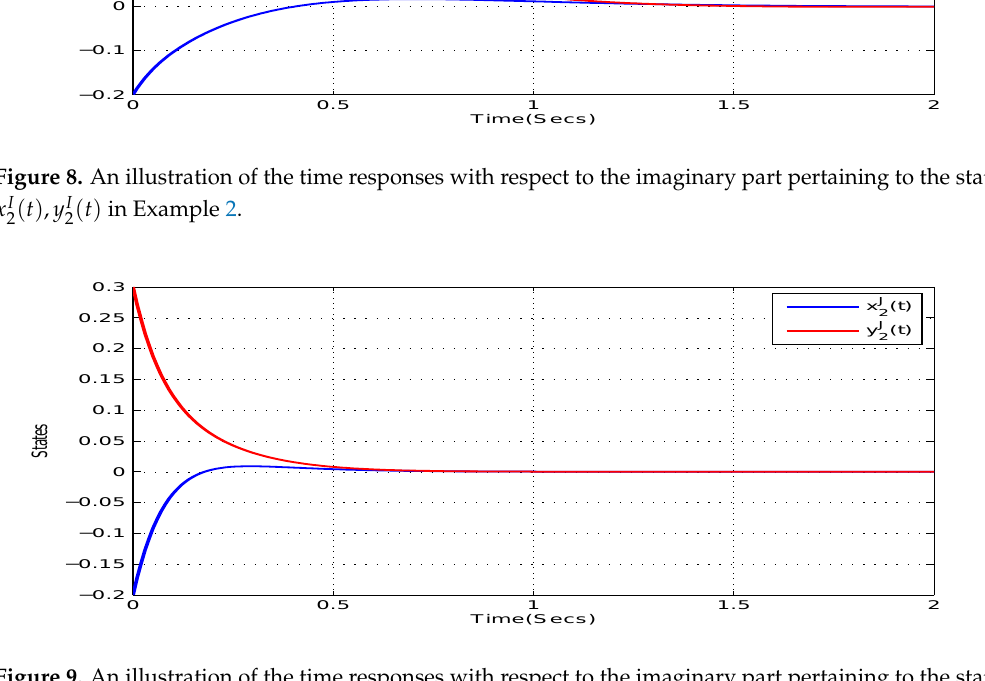
Figure 9. An illustration of the time responses with respect to the imaginary part pertaining to the states of ( t ) , y J ( t ) in Example x J 2 2